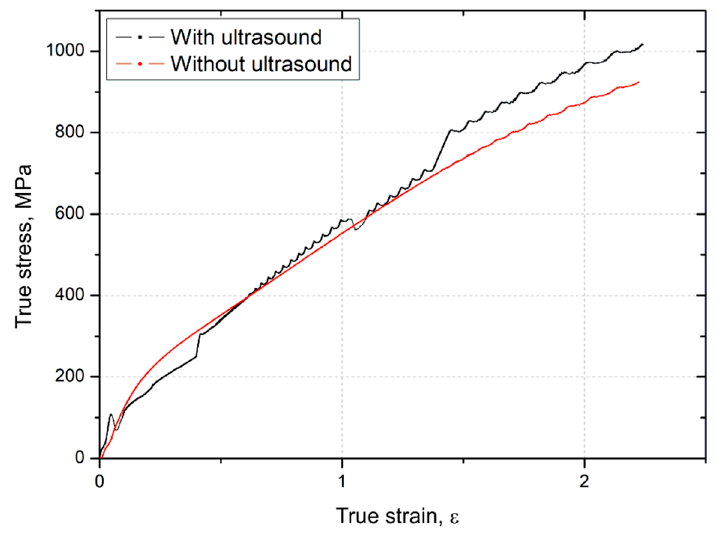
Figure 9. True stresses as a function of strains in the process of upsetting without USV and with the application of USV.